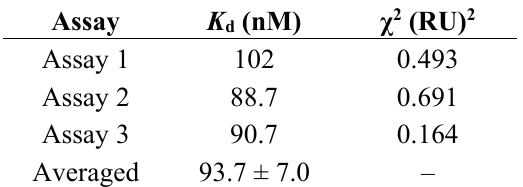
Table 3. Surface plasmon resonance (SPR) affinity data of R12.06 ssDNA MRE.